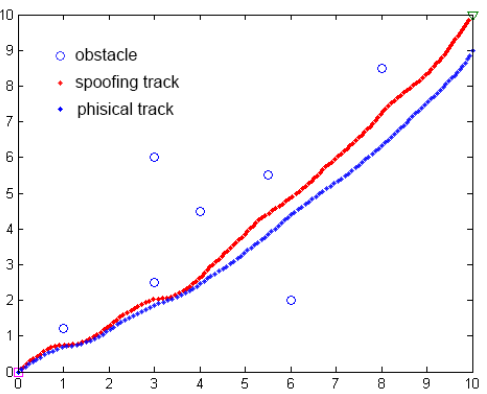
Figure 22. Comparison of path planning simulation before and after GPS spoofing attack based on